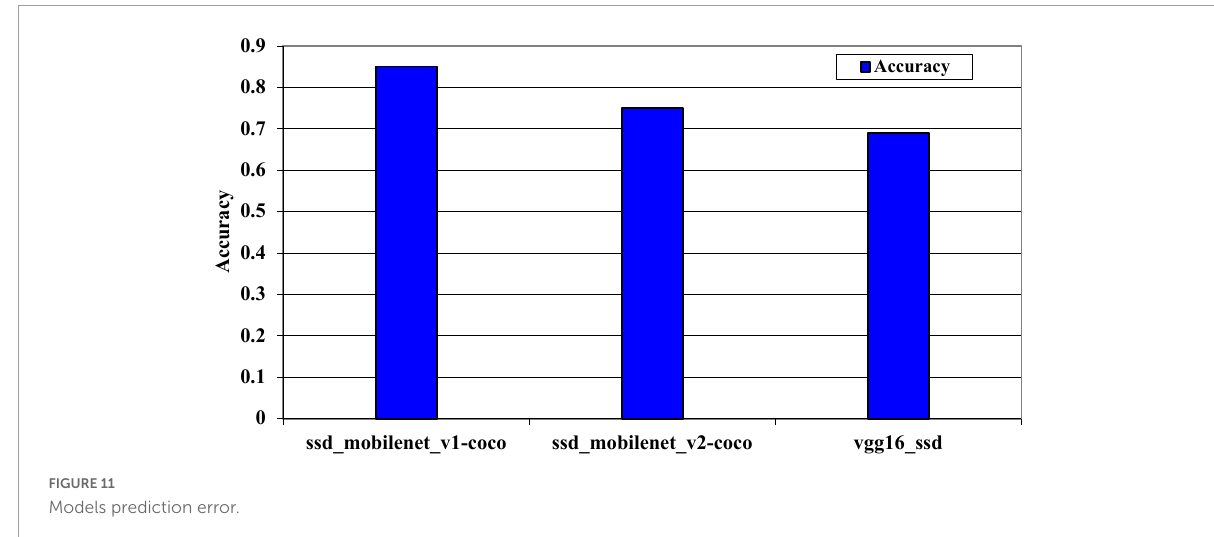
FIGURE11 Models prediction